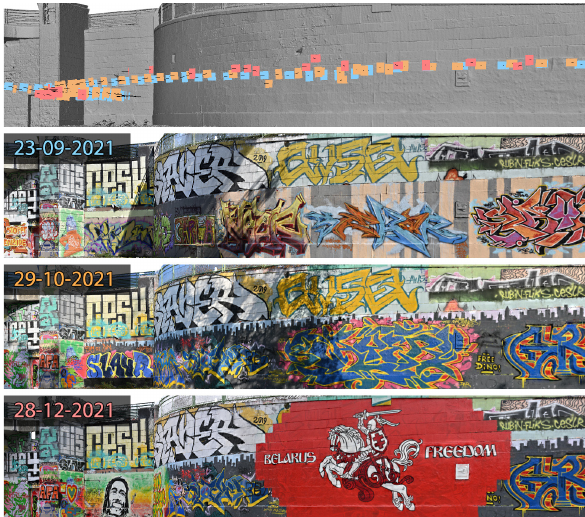
Figure 7 . The upper rendering depicts the exterior orientation of three photo series; the images below present the 3D texture generated from them. Starting from the oriented total coverage photos (in orange), Metashape's incremental SfM managed to orient older September test images (blue) and younger December photos (pink) despite significant changes in the